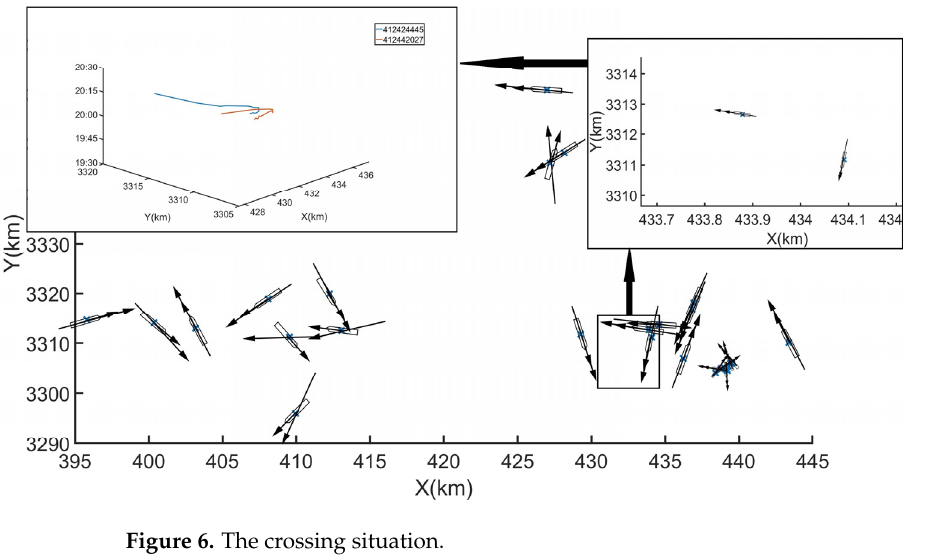
Figure 6. The crossing situation.